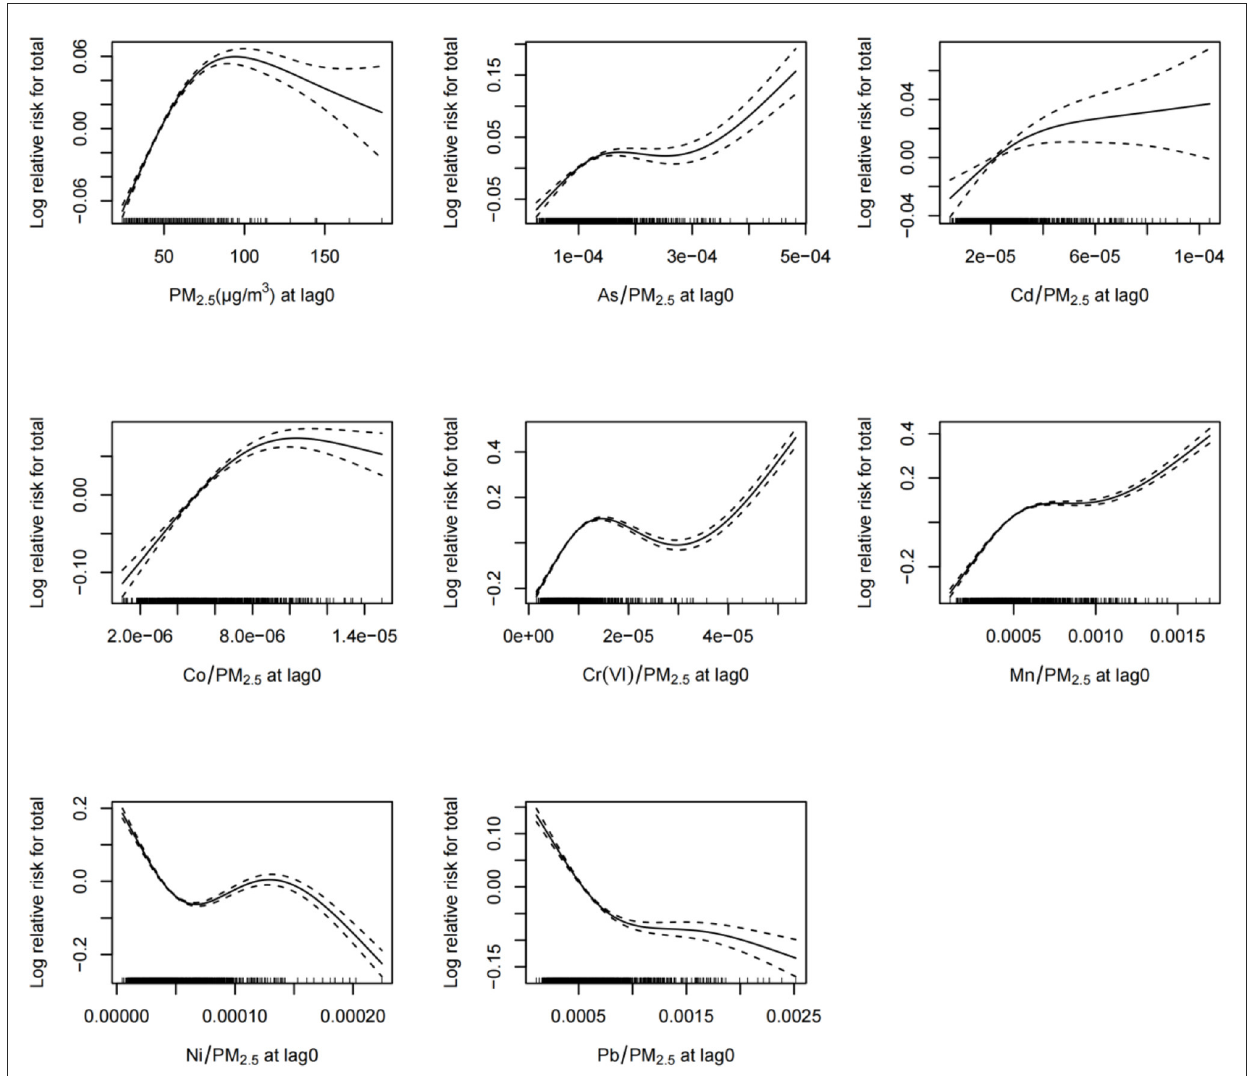
FIGURE6 Exposure–response relationships between the concentrations of ambient PM 2.5 and PM 2.5 -bound metals and total pediatric outpatient visits for respiratory diseases at lag0. CI , confidence interval, dotted line represents confidence interval; solid line represents log relative